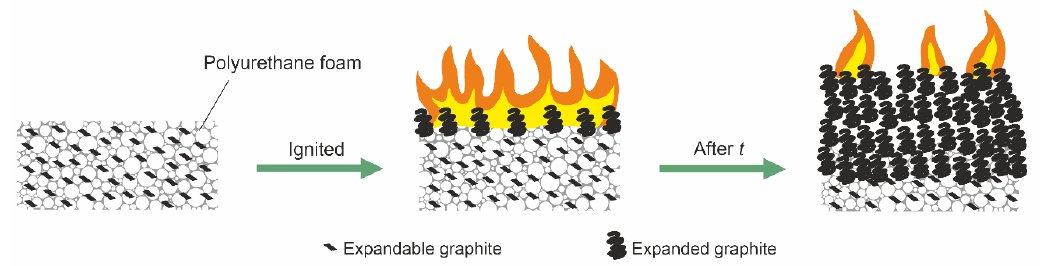
Figure 6. Burning behavior of PUFs with expandable graphite.